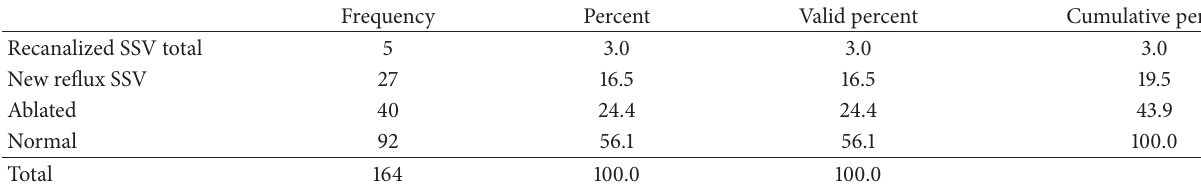
Table 2: Repeat US